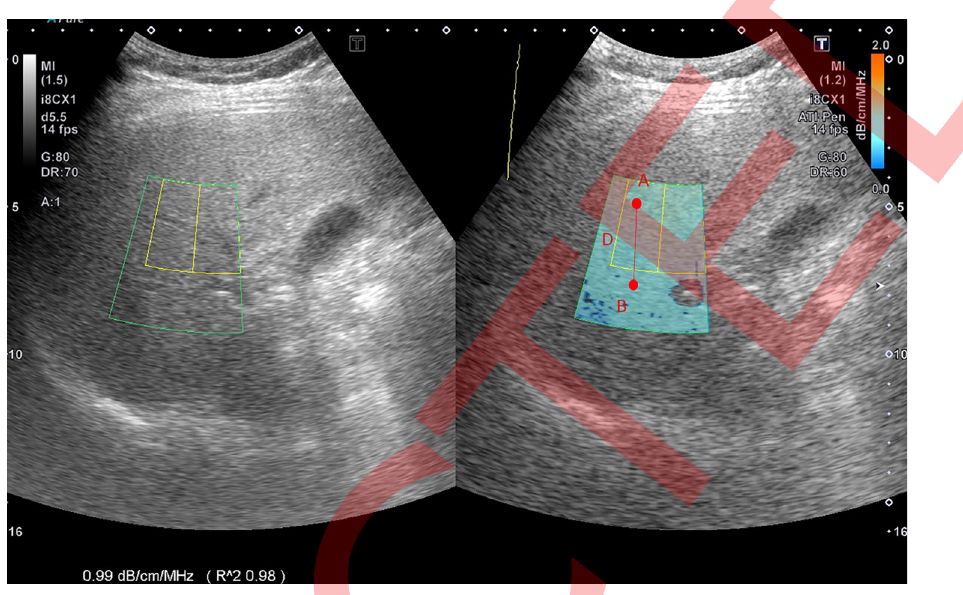
Fig 1. Mechanism of attenuation imaging with ultrasound. The signal difference from point A to point B divided by the distance shows the value of attenuation imaging.